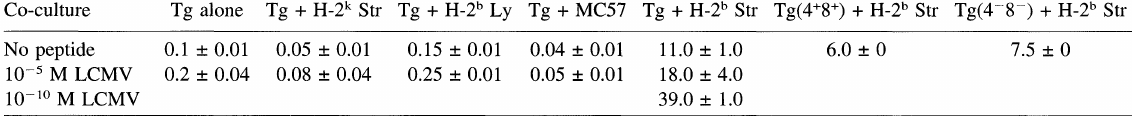
TABLE II Total No. of Recovered CD4-CD8 Transgenic Thymocytes ( 10-3/106 original El7 transgenic cells)